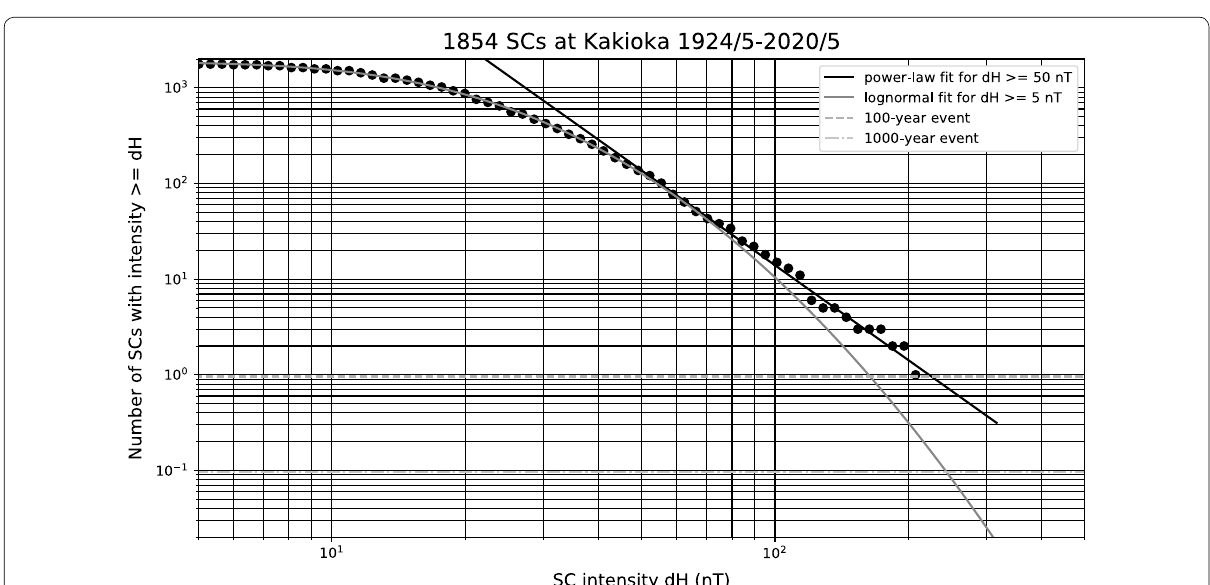
Fig. 4 Cumulative distribution function of 1854 SCs observed at KAK for time interval May 1924 to May 2020. The data points are displayed at even intervals in logarithmic scale. Log-normal and power-law fits are shown by thick and thin solid curves, respectively. The best fitted parameters are α 1.7, μ 1.27, and σ = = =